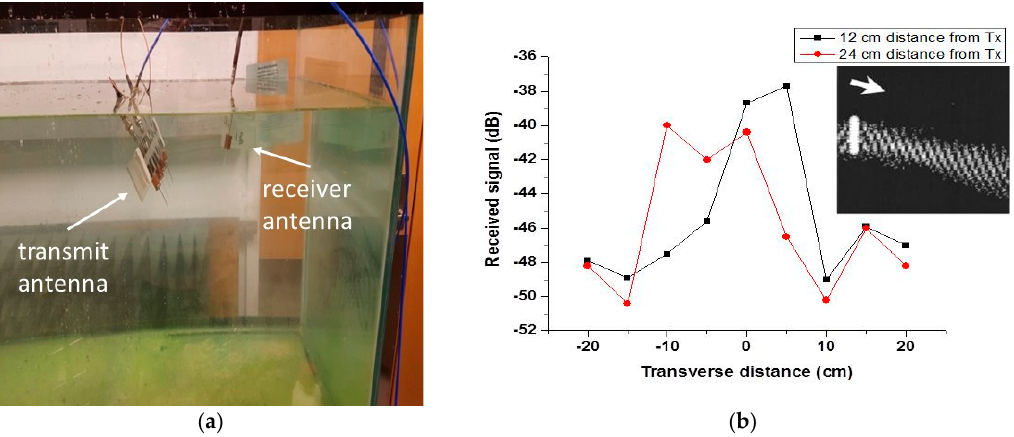
Figure 8. ( a ) 400 MHz SEW field of an antenna array submerged into a fresh-water aquarium is probed by a distant dipole receiver; ( b ) Antenna array field measured in the transverse direction at 12 and 24 cm from the array. The inset shows numerical modeling of SEW directional beaming from the antenna array.